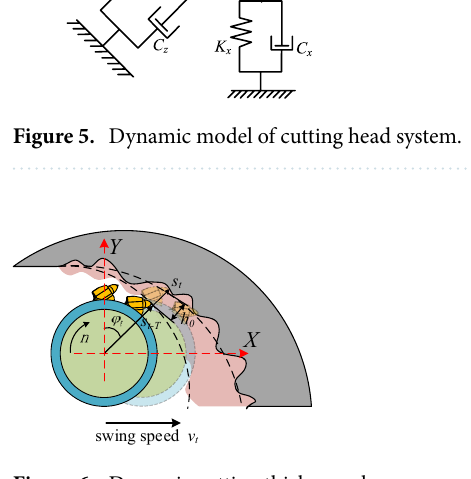
Figure 6. Dynamic cutting thickness